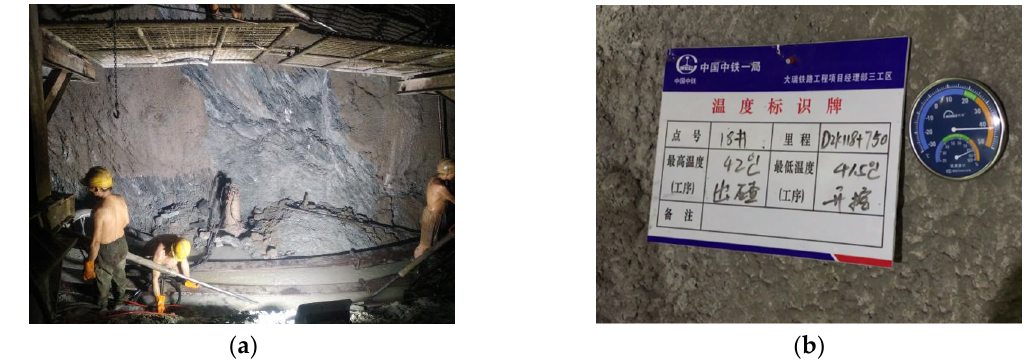
Figure 1. Tunnel with high ground temperature encountered in tunnel construction at present. ( a ) The palm face of a tunnel with high ground temperature; ( b ) the rock temperature of a tunnel with high ground temperature is 42 °C.